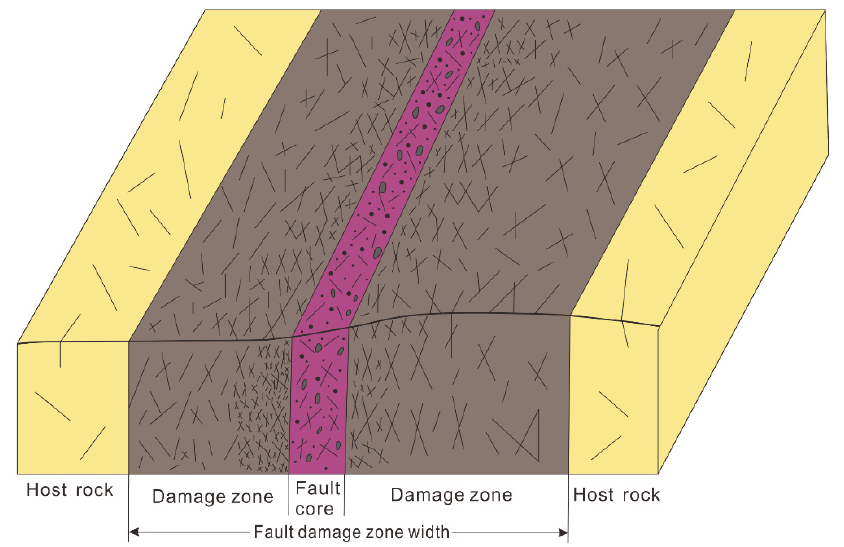
Figure 1. Schematic diagram of Typical strike-slip fault zone structures in carbonate reservoir (modified from Ma et al., 2019).